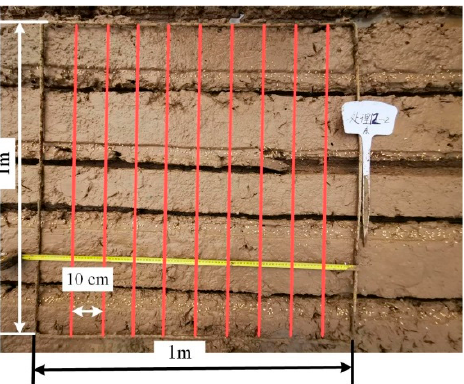
Figure 3. Using a 1 m × 1 m four-frame and a steel ruler to collect the seeding rates in each strip.